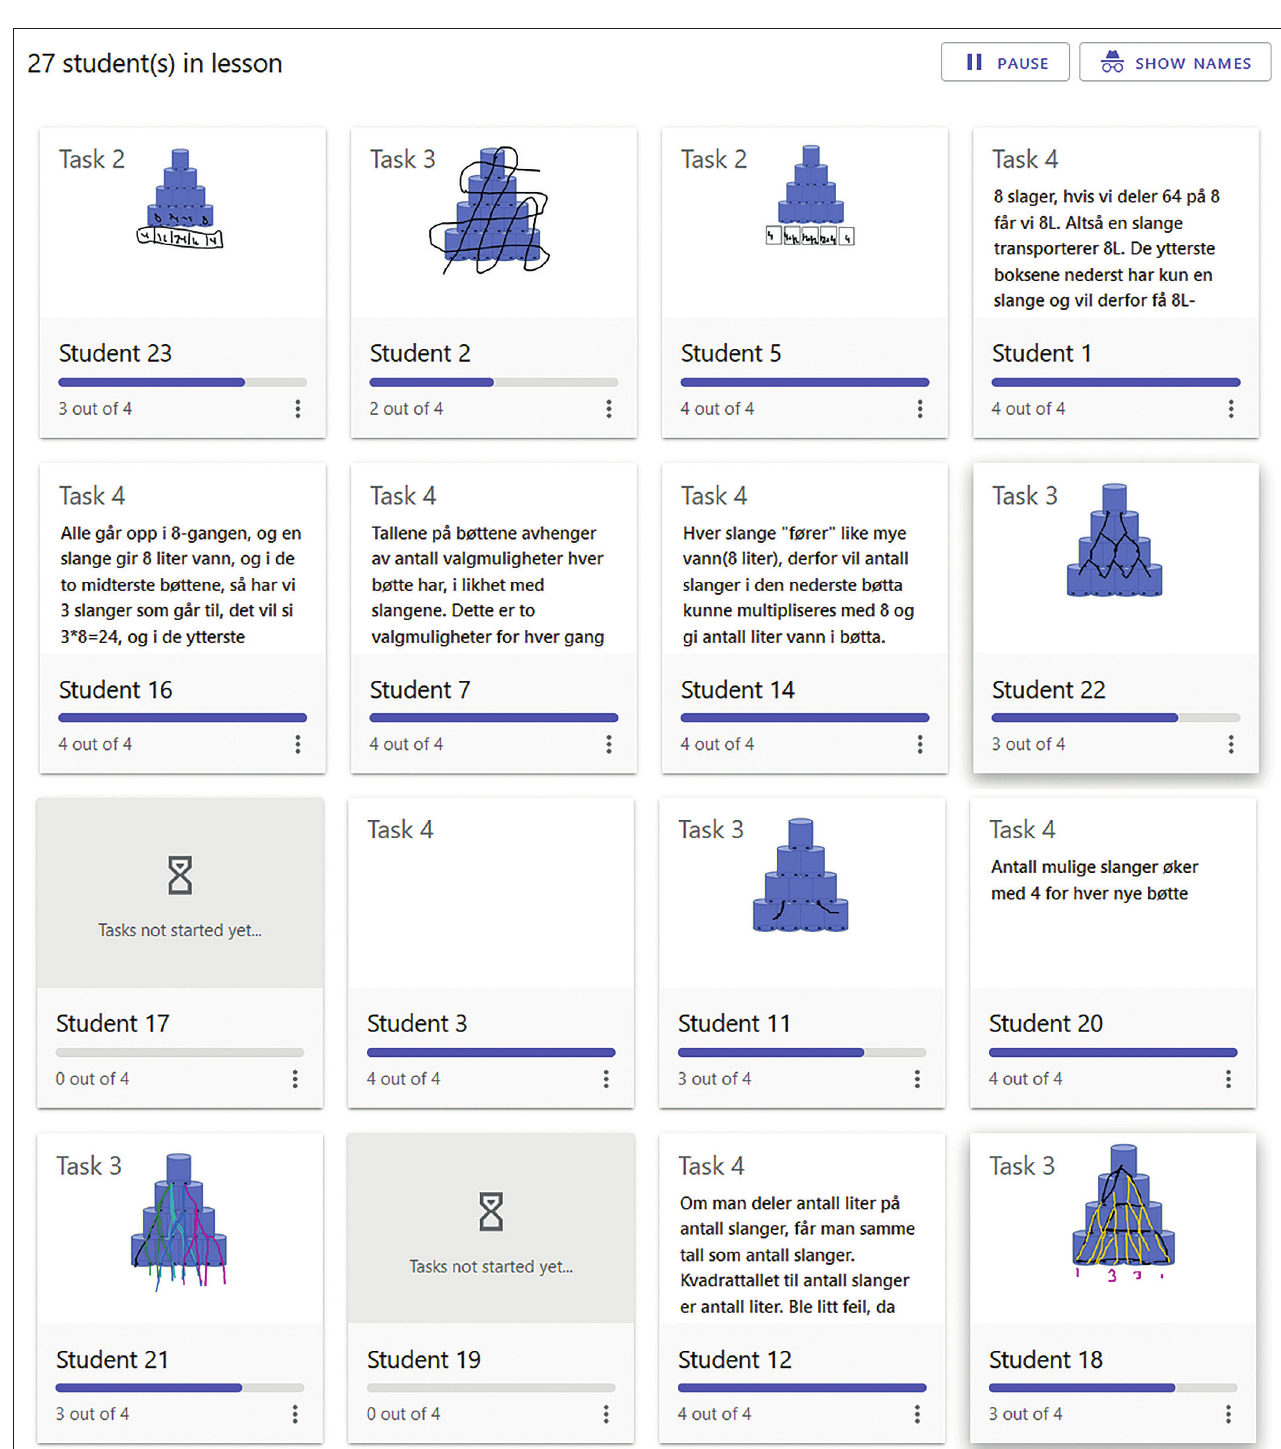
FIGURE 1-A1: Screenshot of the works of Students using the Class function in GeoGebra.